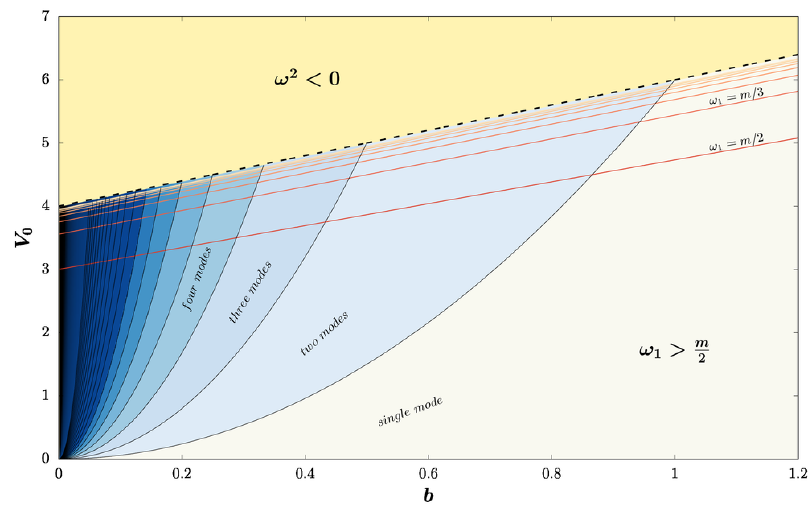
Figure 5 . Spectral structure of even solutions of P(cid:127)oschl-Teller potential. Red and orange lines correspond to values where the frequency of the (cid:12)rst mode is equal to m=n for integer n (cid:21)